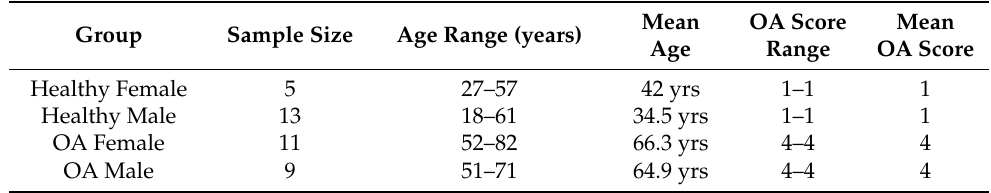
Table 6. The sample size and age information for each